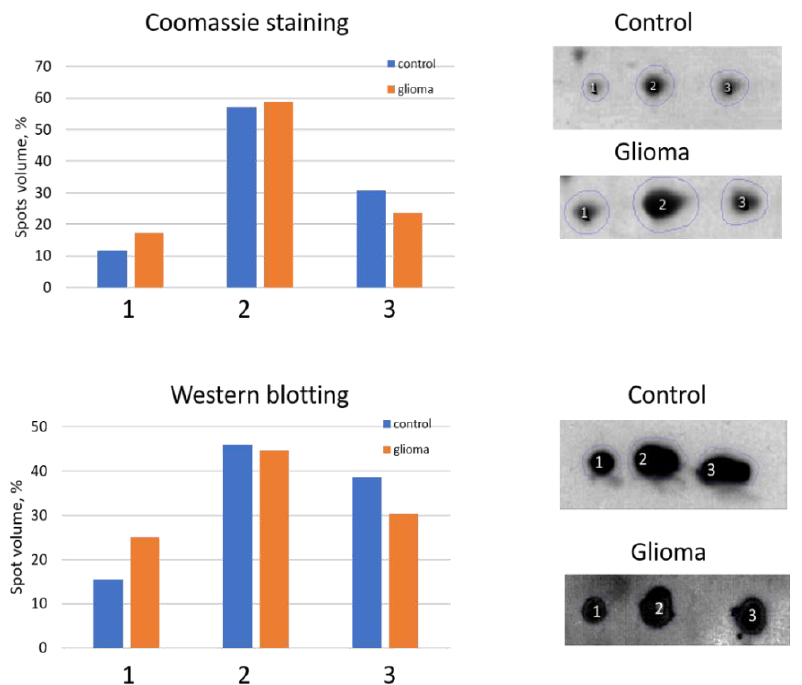
Figure 4. An analysis of three main spots of α 2-chain. The relative intensity of each spot in control or GBM samples was estimated after Coomassie staining ( top ) or Western blotting ( bottom ). The spot numbers are the same as in Figure 3.